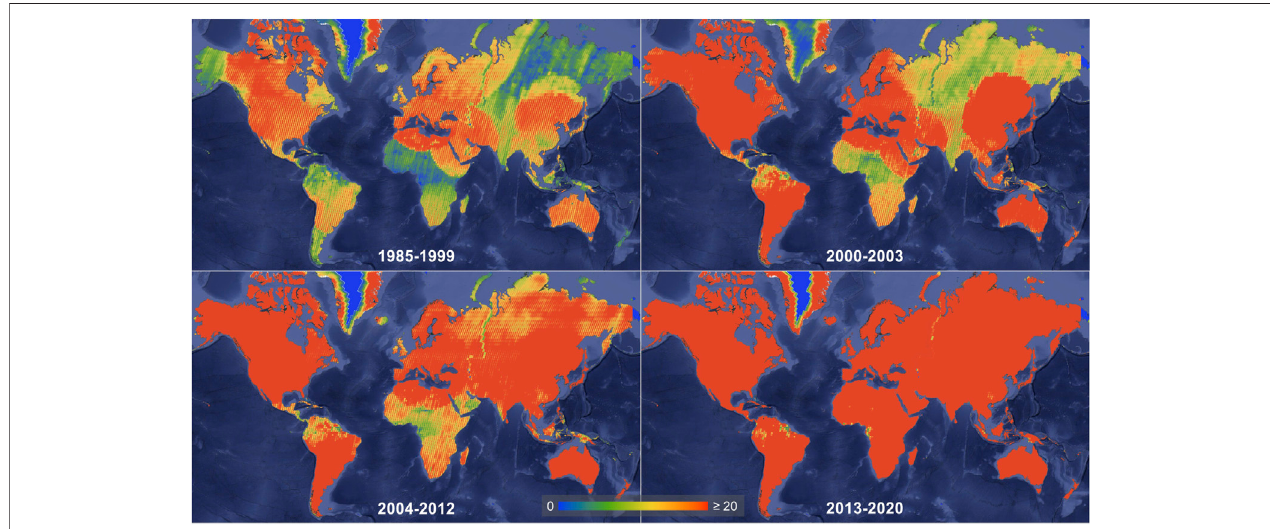
FIGURE 1 | The global average value of the annual number of observations for all images in Landsat archive (TM, ETM+, and OLI data) in four time periods 1) 1985 – 1999 (upper-left); 2) 2000 – 2003 (upper-right); 3) 2004 – 2012 (bottom-left); 4) 2013 – 2020 (bottom-right).